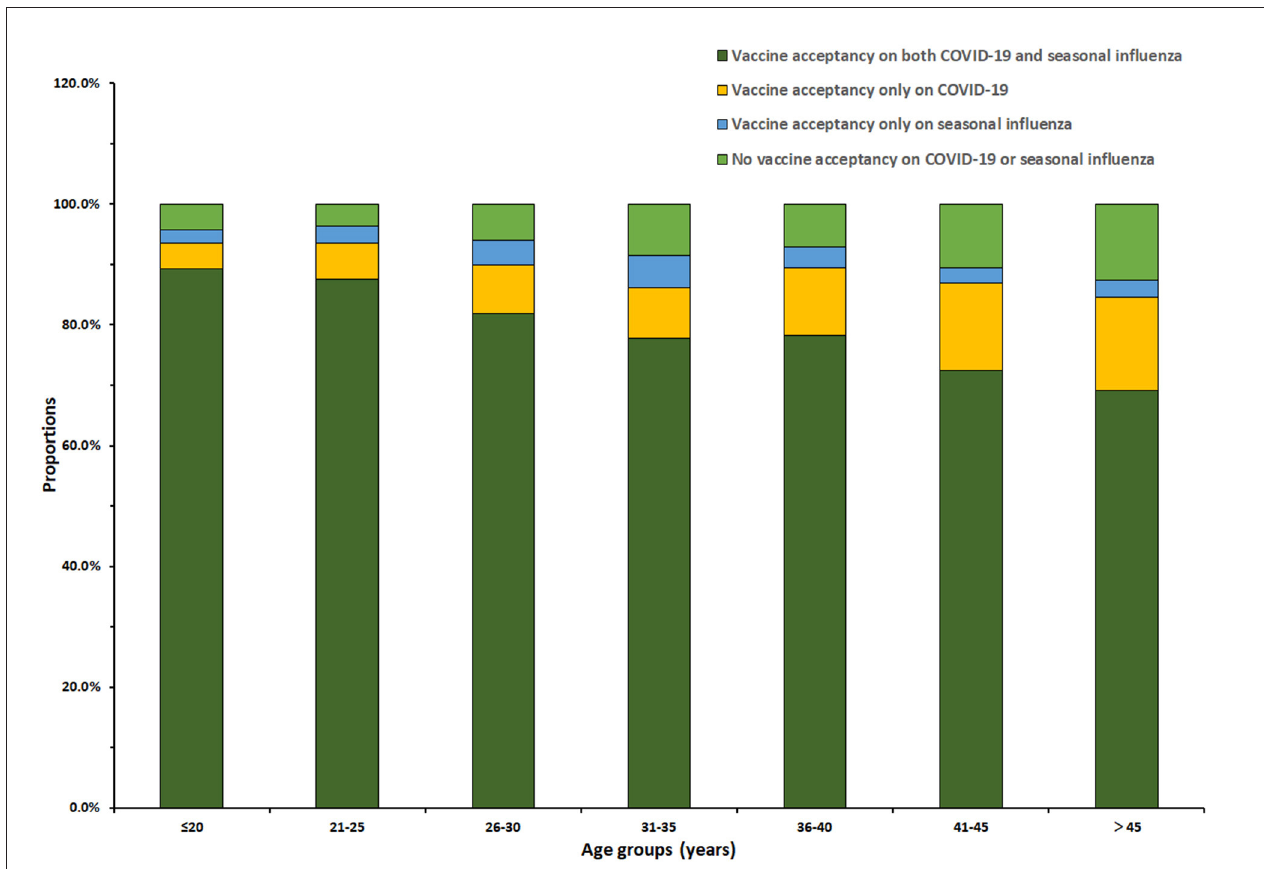
FIGURE 1 | Distribution of seasonal influenza and COVID-19 vaccine acceptance by age